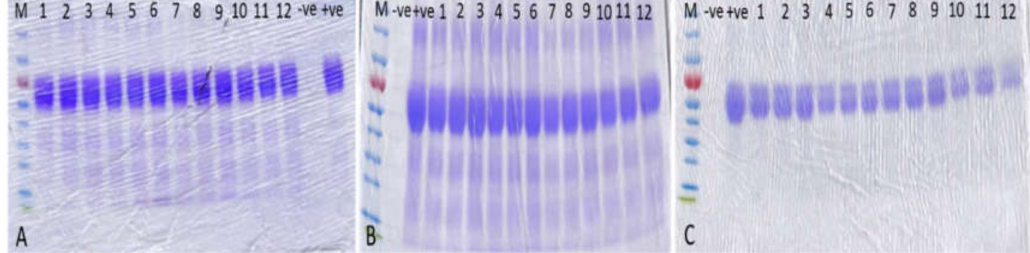
Figure 6. Stability test on released toxoid. SDS-PAGE analysis of protein released from the various MSNPs after ( A ) 0 months ( B ) 3 months ( C ) 6 months. The samples were kept under the following conditions A1: In suspension, kept at 4 ◦ C, A2: In suspension, kept at RT, A3: Lyophilised, kept at 4 ◦